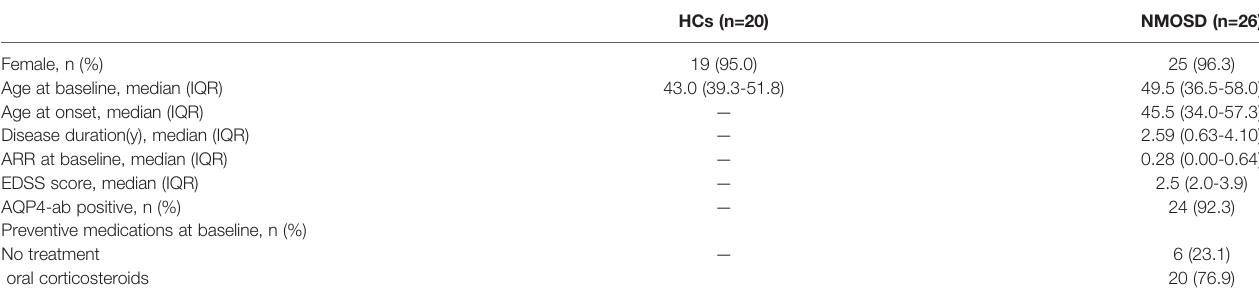
TABLE 1 | Demographics of participants in the